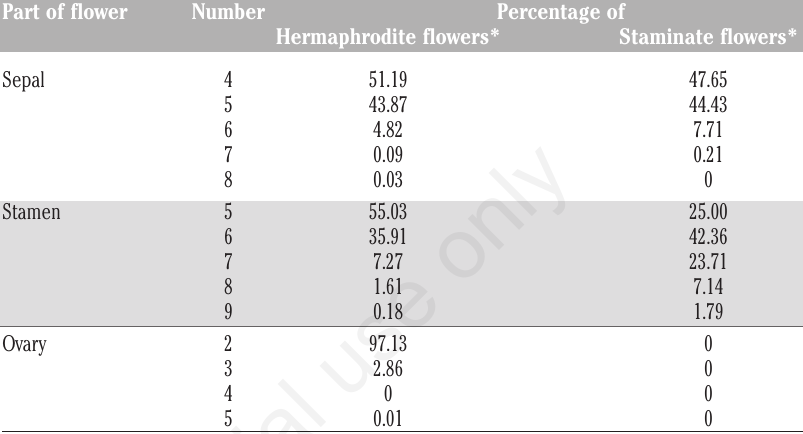
Table 2. Percentage of pulasan flower